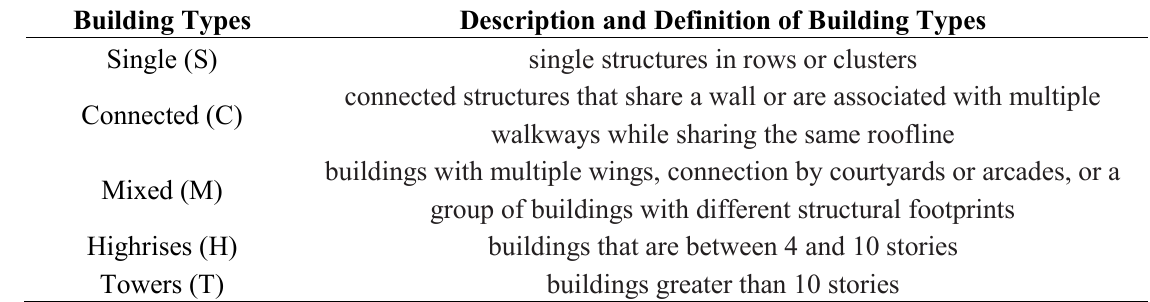
Table 1. The five types of different